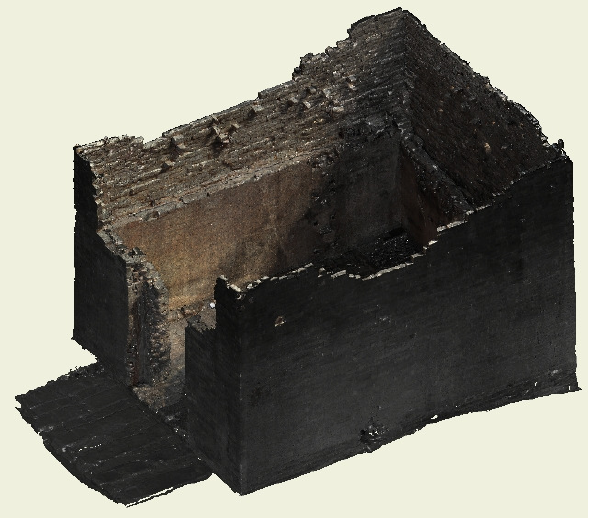
Figure 5: Perspective view of the virtual 3D model of the Almaqah temple, generated as a mesh in the software Geomagic